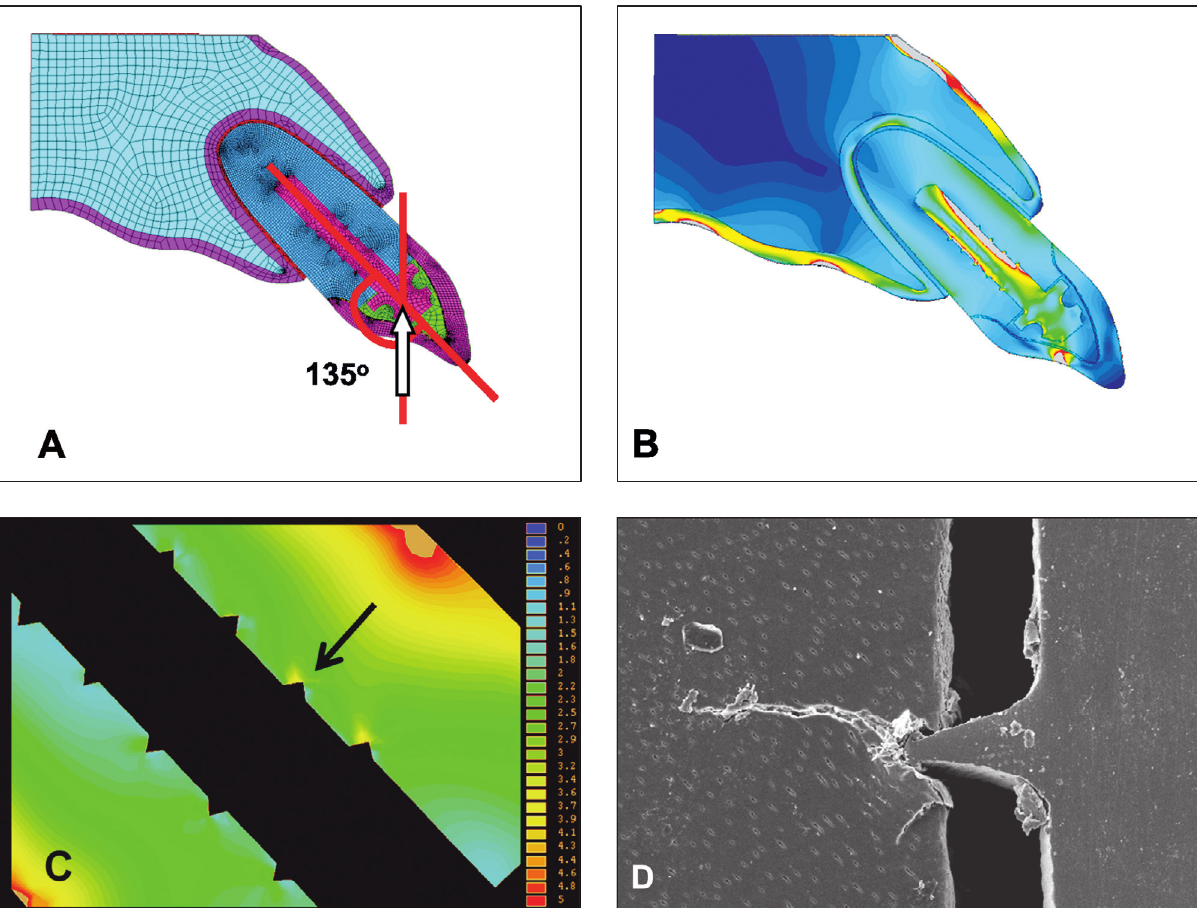
Figure 2 - A: External and internal contour; meshed model; load application on palatine face; B: Equivalent Von Mises stress dis- tribution; C: High stress concentration at the post thread end in the Radix-Anker model; D: Crack formed by Euro-Post